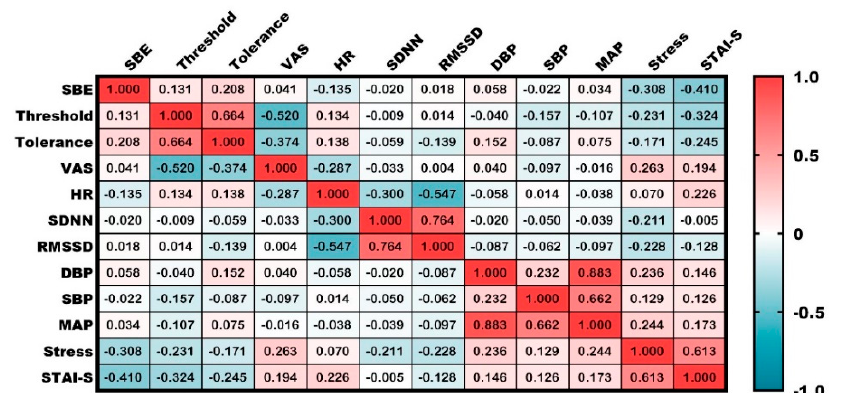
Figure 5. Correlation of measured indices. Numbers in the cells represent Pearson’s r. Analyzed via Pearson’s correlation analysis.